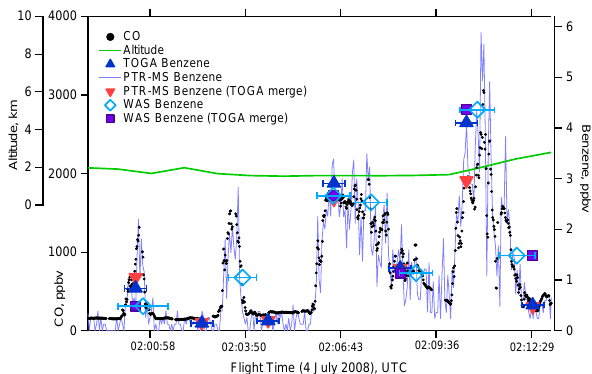
Fig. 3. Time series plot of CO, benzene observations and TOGA- merge values for benzene during a section of the 4 July 2008 ARC- TAS DC-8 flight. Error bars show the start and stop times of the WAS and TOGA integrated sampling